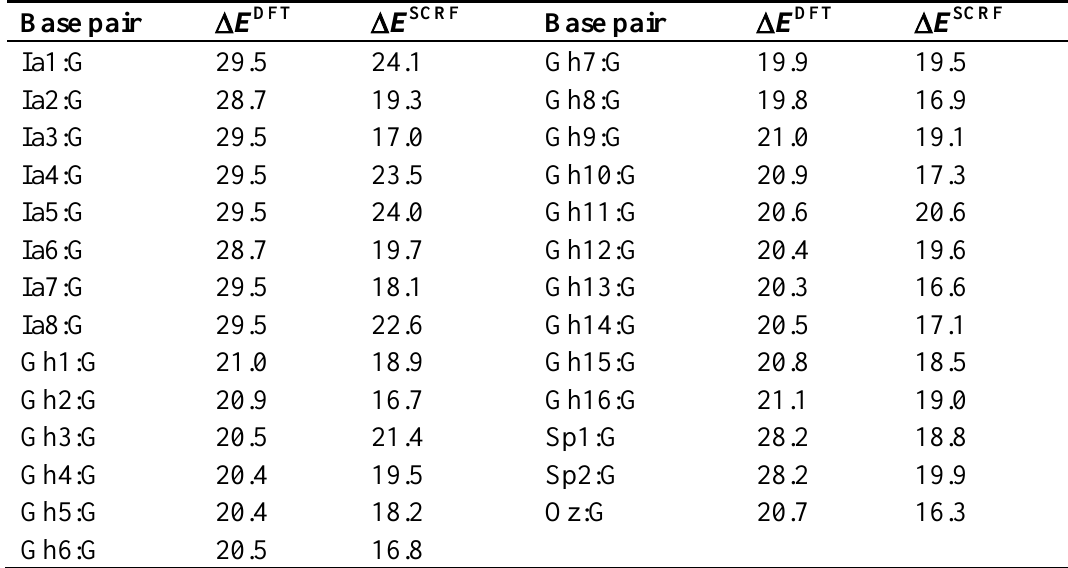
Table 1. Stabilization energies (kcal/mol) of base pairs, obtained from the B3LYP/6-31G**-optimized geometries a .